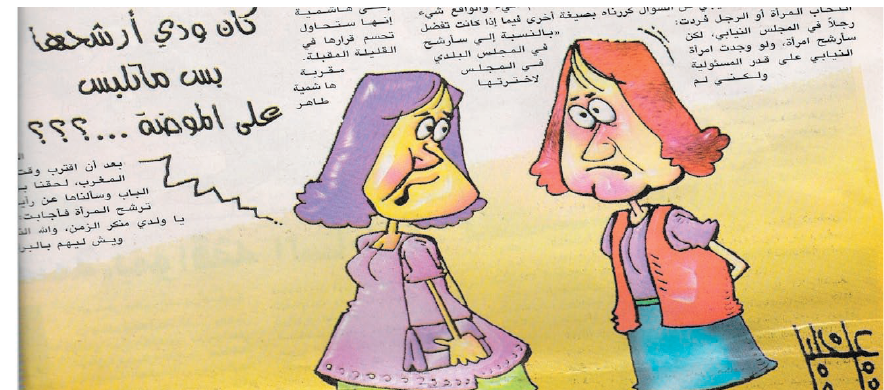
Figure 3: Patronizing‐stereotyping cartoon